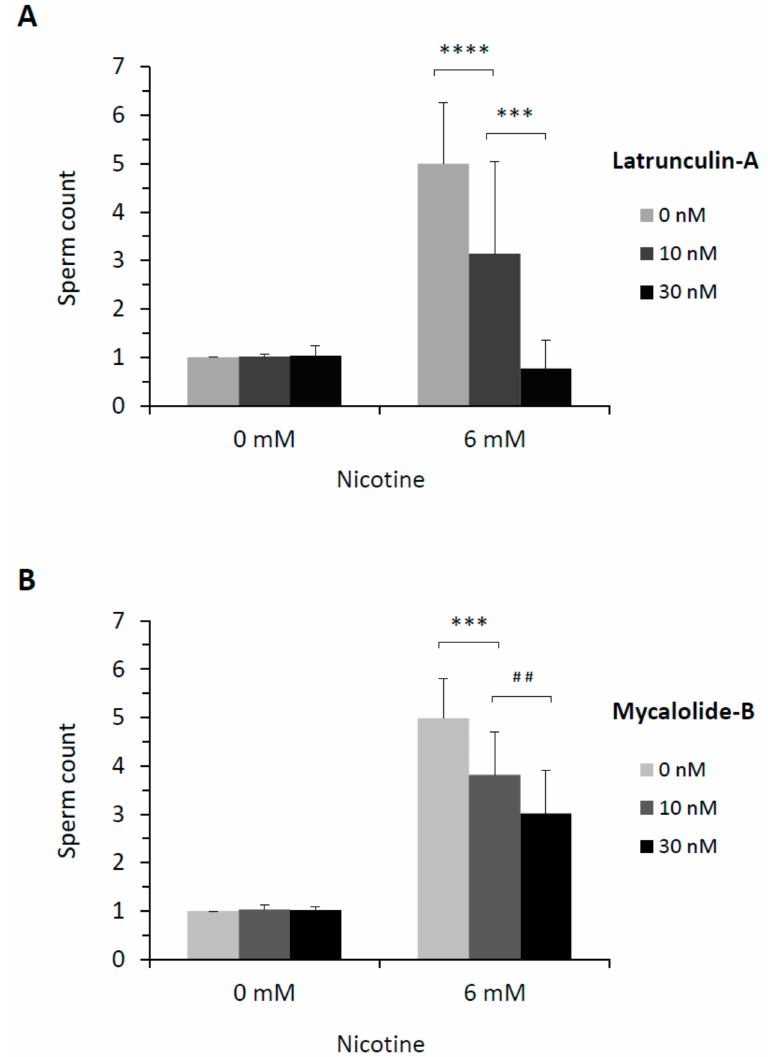
Figure 5. Nicotine-induced polyspermy is inhibited by actin drugs in a dose-dependent manner. P. lividus eggs were pretreated with latrunculin A ( A ) or mycalolide B ( B ) for 5 min and rinsed twice in NSW prior to the exposure to 6 mM nicotine (5 min). The eggs were then fertilized with Hoechst 33342-prestained sperm, and the number of egg-incorporated sperm was counted 10 min after fertilization. Control eggs without exposure to actin drugs (0 nM) received the same pretreatment with the vehicle of the drugs (0.1% DMSO). Data were pooled from 4 (latrunculin-A) or 3 (mycalolide B) independent experiments. Each treatment in one experiment comprised 20 eggs from the same batch (n = 80 or 60, respectively). U-test: **** P < 0.00001, *** P < 0.0001, ## P <